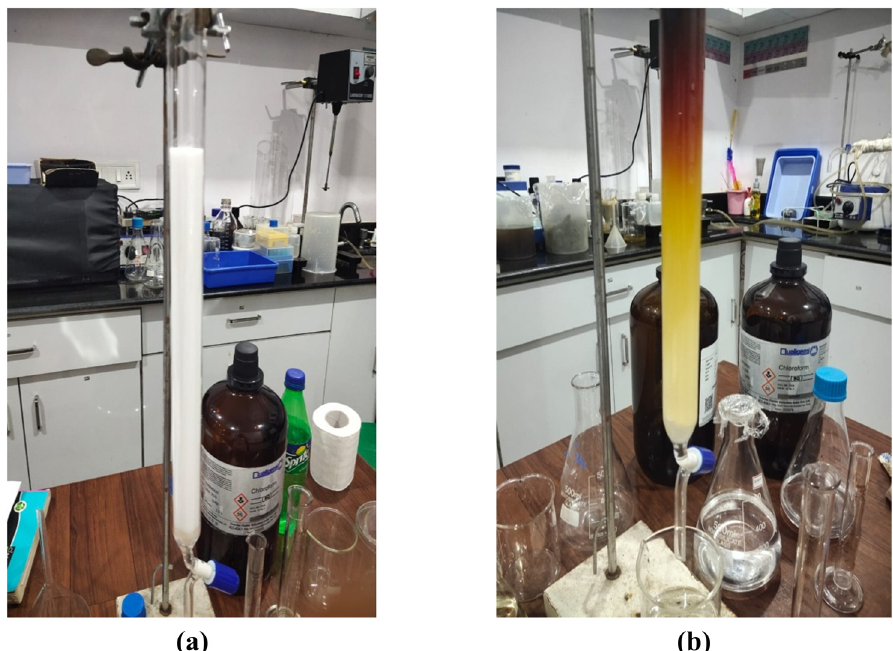
Figure 2: Fractionation by column chromatography: ( a ) column packed with silica gel and ( b ) column loaded with crude AE of R. mucronata .